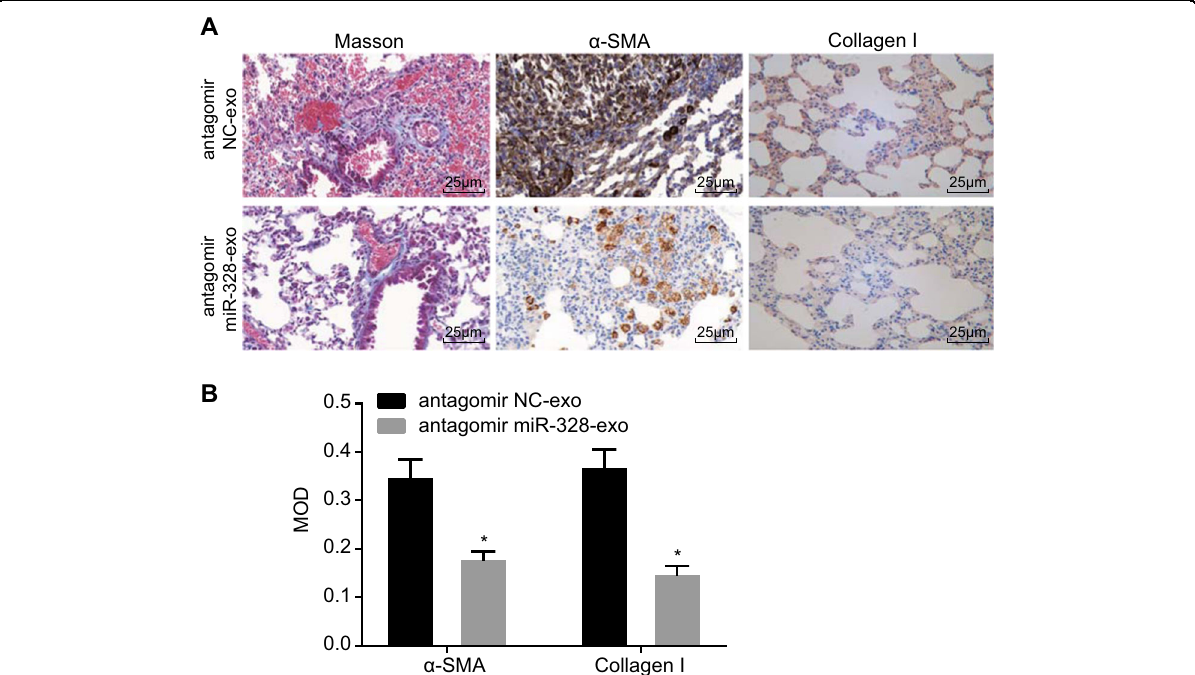
Fig. 8 Knocking down exosomal miR-328 expression in M2 macrophages inhibits the progression of PF in vivo . a The degree of fi brosis and expression of α -SMA and Collagen I observed by Masson staining and IHC, respectively, in the antagomir NC-exo and antagomir miR-328-exo groups (400× ). b MOD values of α -SMA and Collagen I. * p < 0.05 vs . the mimic NC-exo group. miR-328, microRNA-328; NC, negative control; and α -SMA, α - smooth muscle actin. The results were measurement data and were analyzed using an unpaired t test. The results are expressed as the mean ± standard deviation. The experiment was conducted in